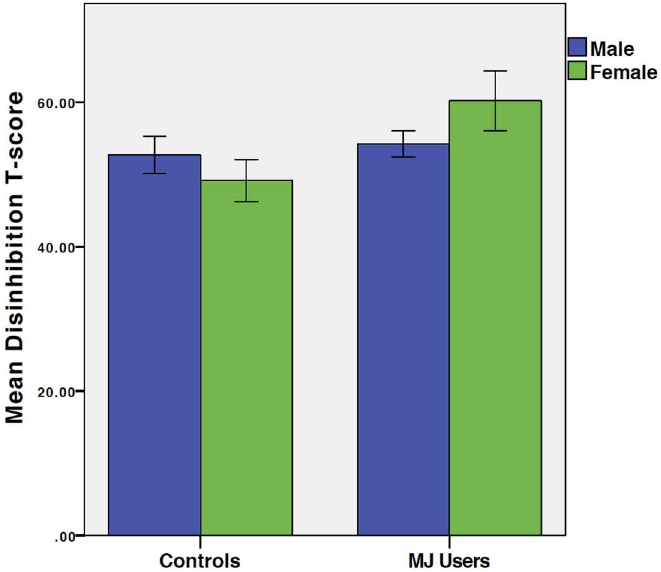
Fig 2. Disinhibition by Group and Gender. Mean FrSBe Disinhibition T-score by group (left: controls; right: MJ users) and gender(blue: males; green: females). Results demonstrate that female MJ users have significantly higher disinhibition than same-gendered controls and